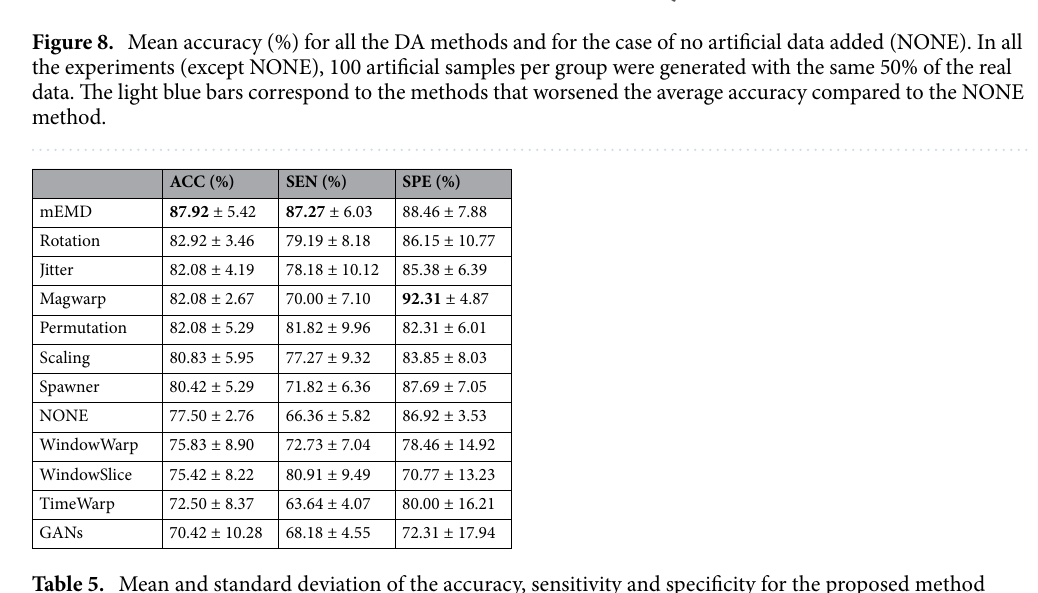
Table 5. Mean and standard deviation of the accuracy, sensitivity and specificity for the proposed method based on mEMD, plus 10 data augmentation methods and NONE (no data augmentation). The methods are listed from highest to lowest accuracy. Best cases are highlighted in